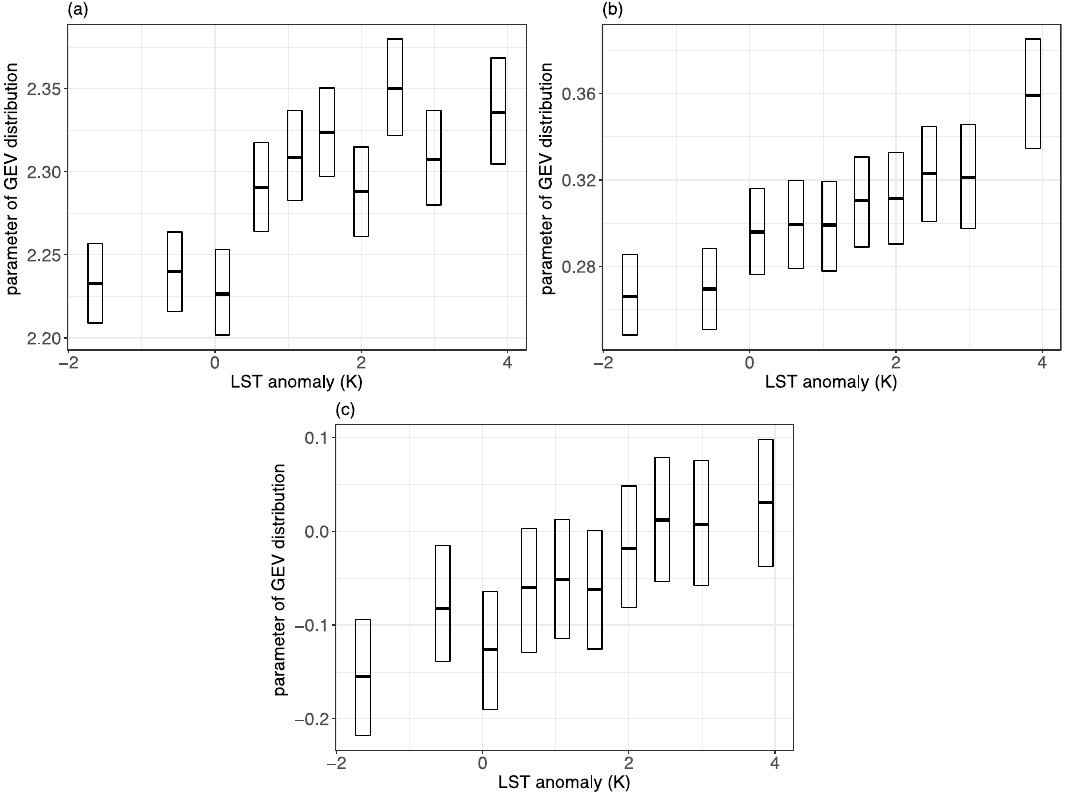
Figure 11. Plot of location a ( a ), scale b ( b ) and shape s ( c ) parameters of generalized extreme value distribution of log-transformed fire duration and their 95% confidence intervals, conditional to LST anomaly in 10 decile bins.